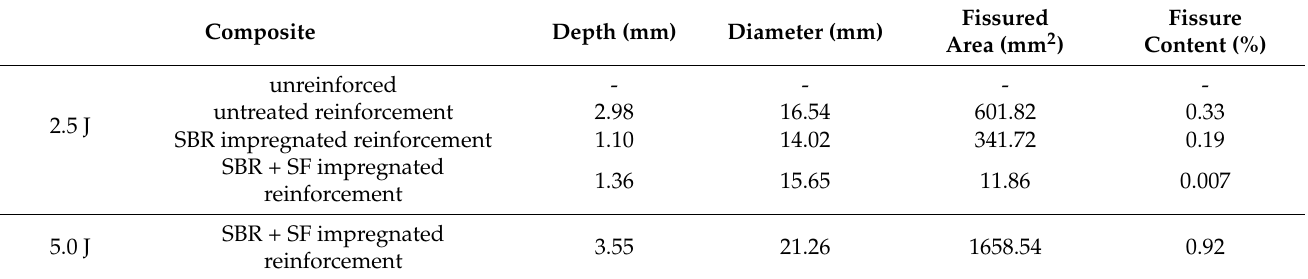
Table 4. Average depth, divot diameters, and fissured area from impact testing on all composites.